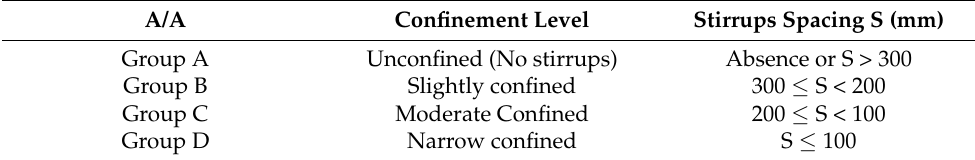
Table 3. Proposed groups of confinement level depending on the stirrups spacing in RC elements. A/A Confinement Level Stirrups Spacing S (mm) Group A Unconfined (No stirrups) Absence or S > 300 Group B Slightly confined Group C Moderate Confined Group D Narrow confined S ≤